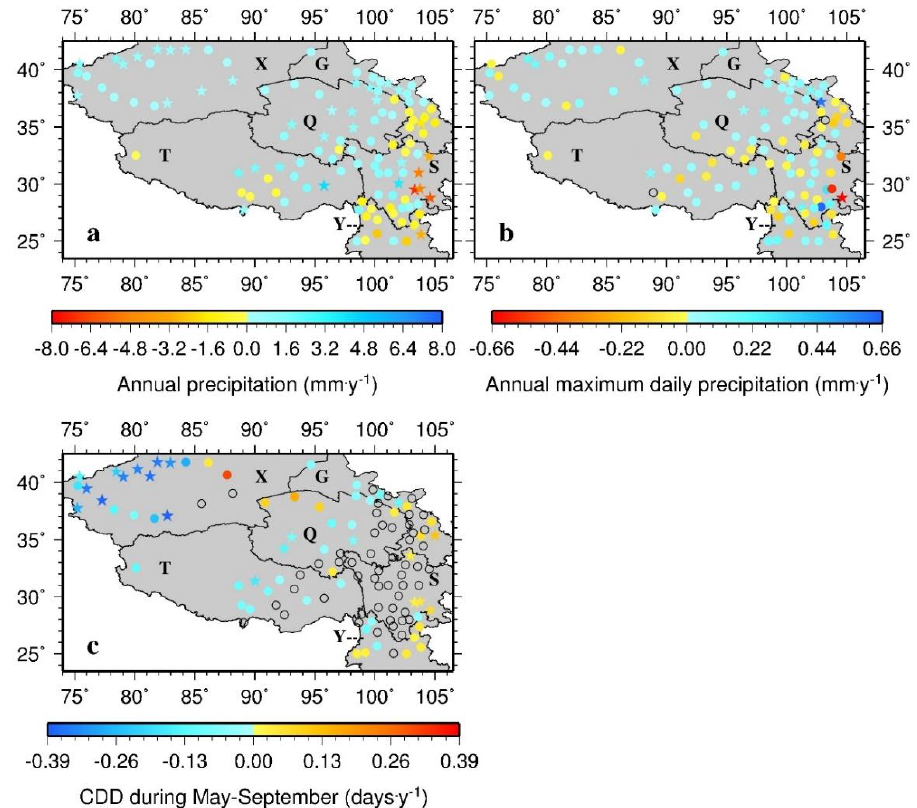
Figure 5. ( a – c ) Spatial distributions of the trends of annual precipitation variables during 1963– 2015.